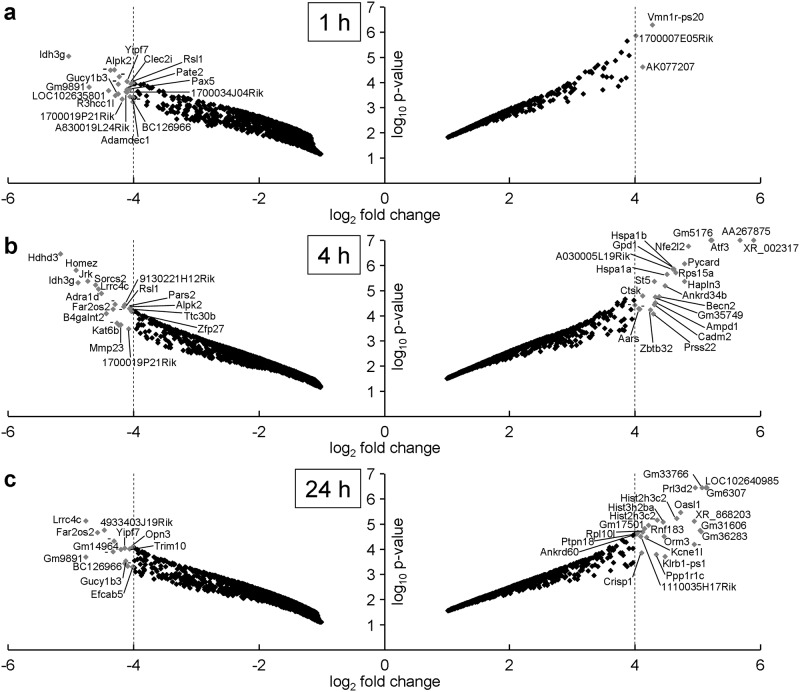
Volcano plot analysis of modulated genes at each time point.Volcano plots showing genes modulated with a fold change above 2 of below 0.5 after a) 1 h, b) 4 h or c) 24 h of pressurization. The base 2 logarithm of the fold change for each gene is plotted against the base 10 logarithm of the p-value obtained from the rank product analysis. The names of the genes with a fold change greater than 16 or less than 0.0625 (represented by the vertical dotted lines) are written next to the corresponding points.